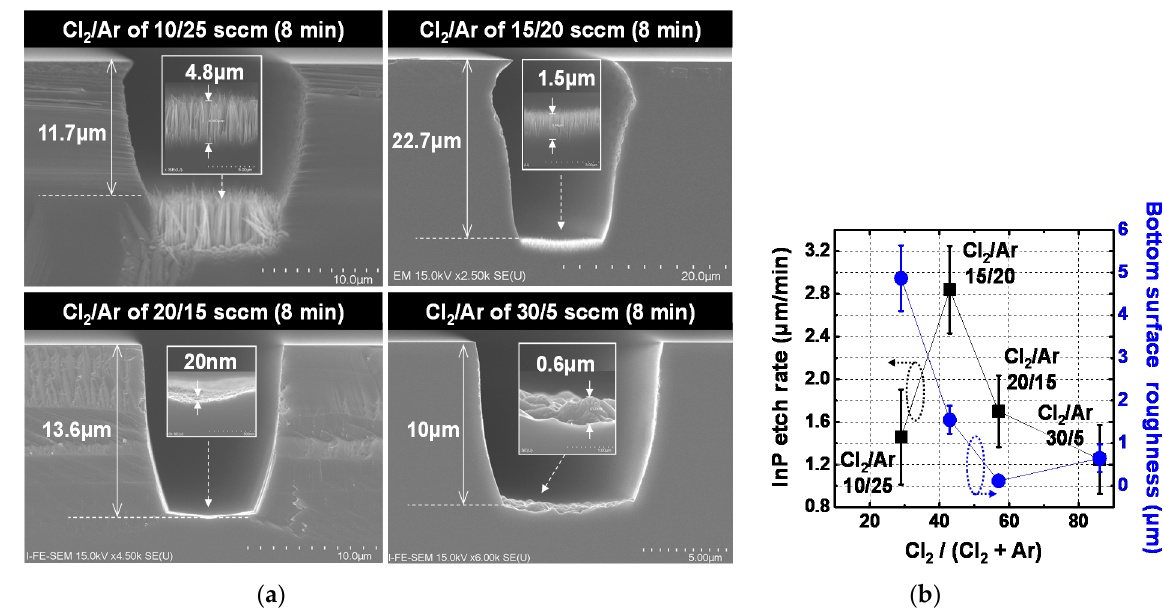
Figure 5. Fabrication results of InP via holes etched at Cl 2 /Ar gas mixtures with different ratio of 10/25, 15/20, 20/15, and 30/5 sccm: ( a ) SEM images of representative etch profiles and ( b ) InP etch rate and bottom surface roughness of fabricated InP via holes. Error bars in Figure 5b represent the deviation values for a total of 60 InP via holes with the identical layout pattern in the three fabrication lots. Total gas flow rate, ICP power, RF power, operation pressure, and operation temperature of the ICP etcher were 35 sccm, 1200 W, 294 W, 5 mT and room temperature, respectively.